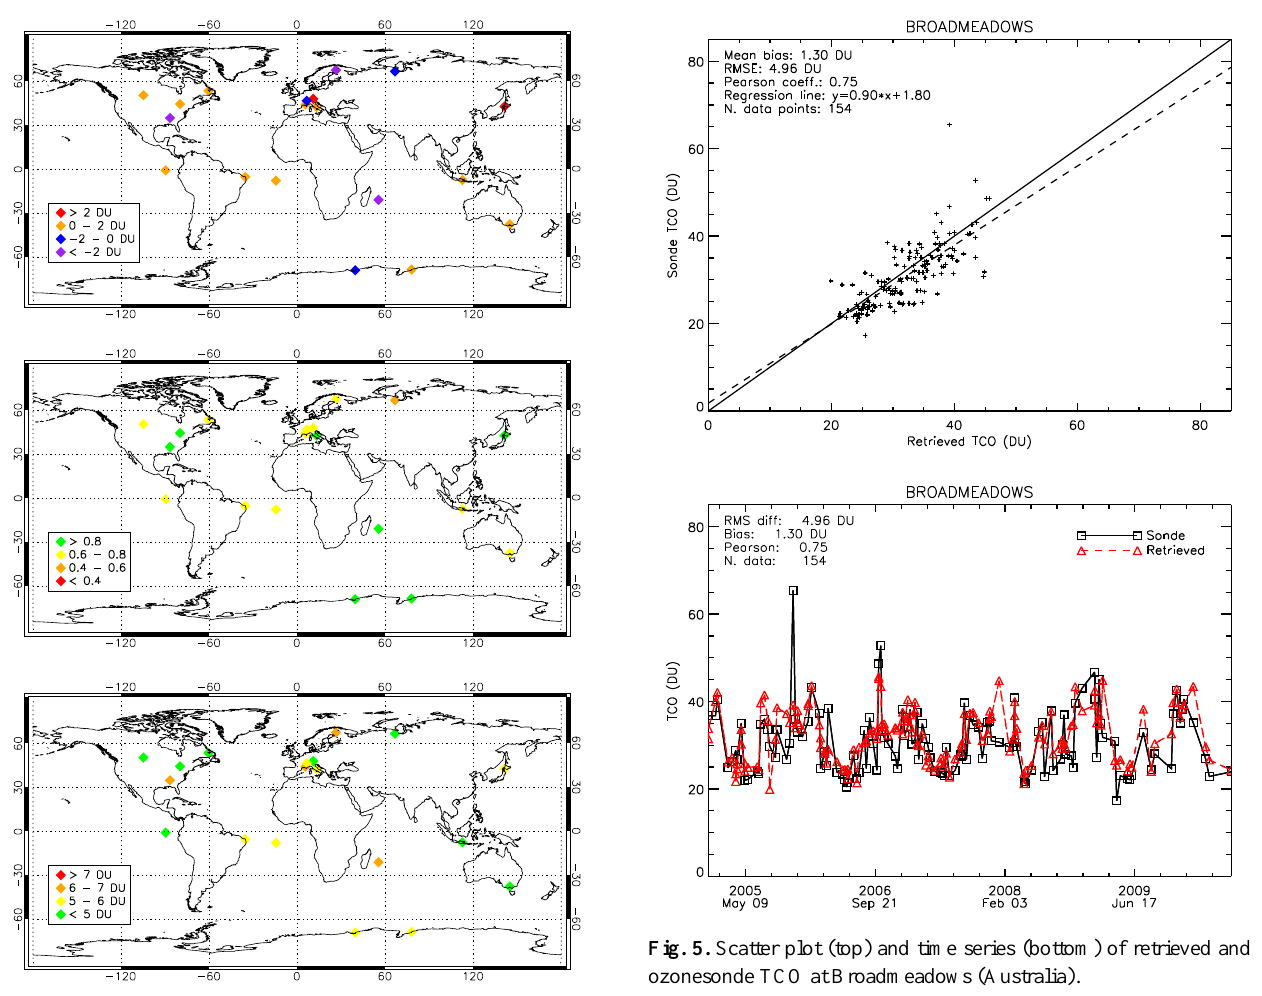
Fig. 4. Mean bias (top), Pearson correlation coefficient (middle), and RMS difference (bottom) between ozonesonde measurements and retrievals for all the measurement stations having at least 35 measurements in the test dataset.